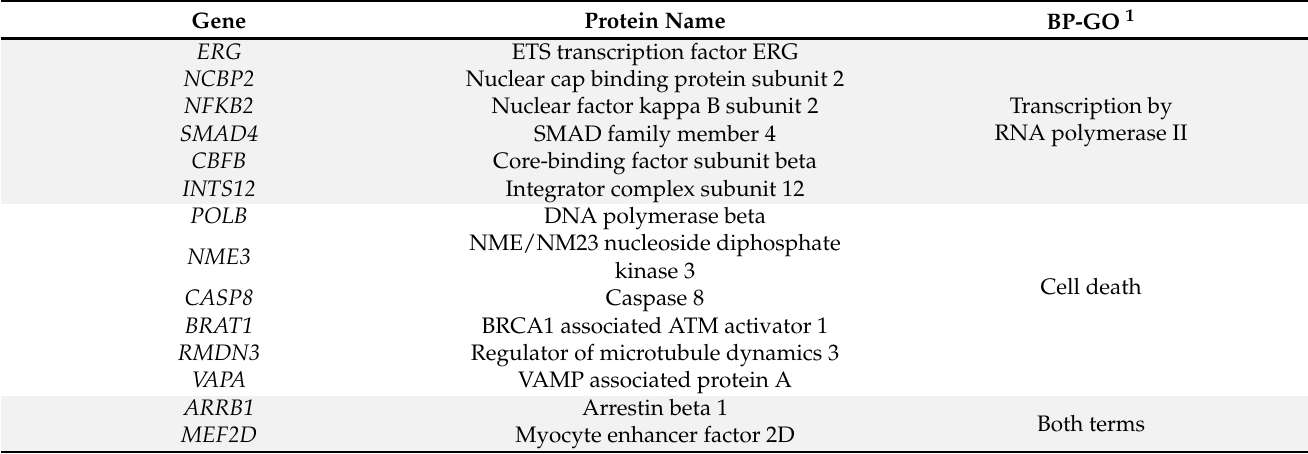
Table 2. Upregulated proteins in non-responder patients sampled before treatment (PRE-NR) involved in several biological